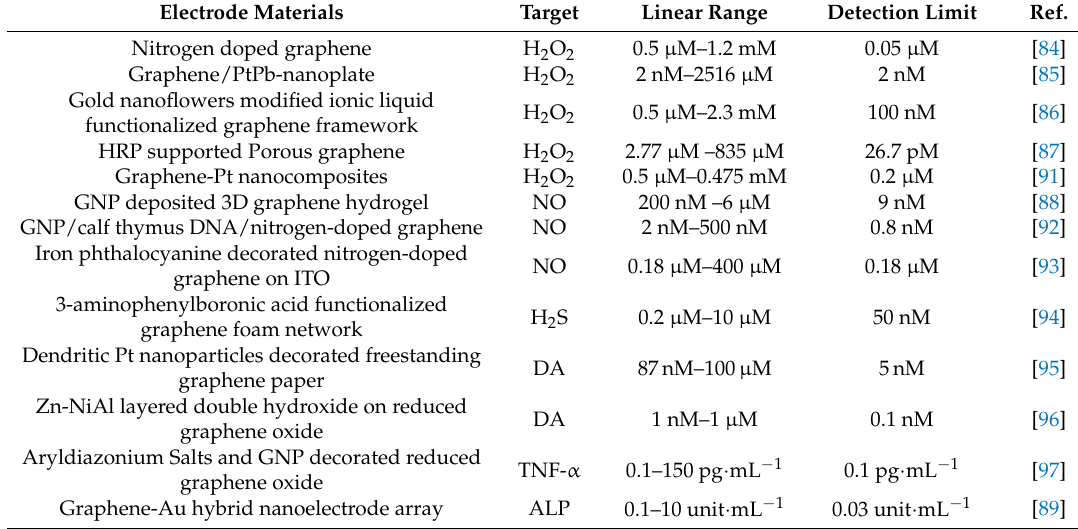
Table 4. Comparison of different graphene-based electrode for live cell-based